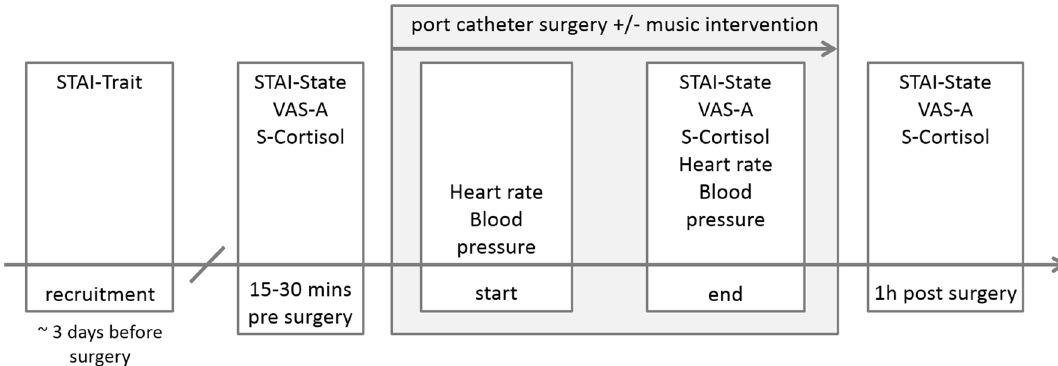
Figure 3. Procedure of the study highlighting which measures were obtained at the different time